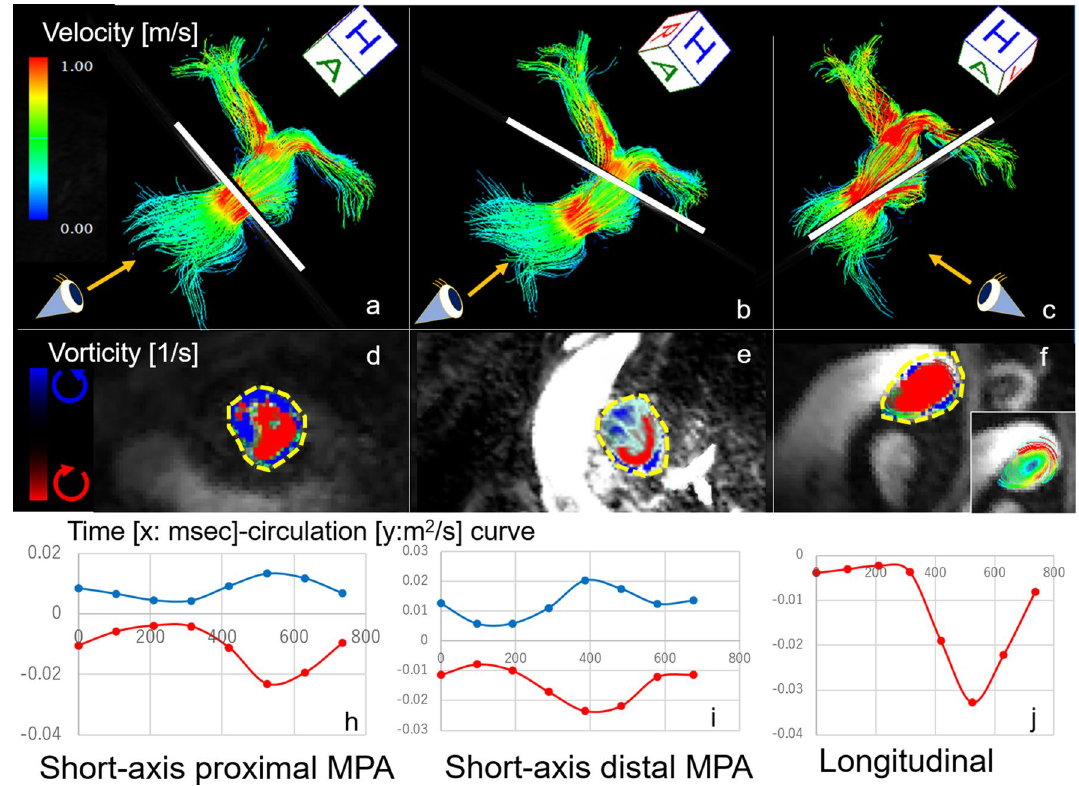
Figure 4. Streamline imaging flows of the pulmonary arteries of a 40-year-old man with repaired TOF (Case 6). The leftmost image and middle image show short-axis vorticities; the rightmost image shows a long-axis vorticity. The white lines in the uppermost row, where the vorticity was calculated, correspond to the cross sections shown in the middle row. The location of the measurement in the proximal MPA occurred at 1 cm above the pulmonic valve ( a : white line). The location of the measurement in the distal MPA occurred at 1 cm below the bifurcation of the MPA into the right and left pulmonary arteries ( b : white line). The longitudinal circulation was measured parallel to the clockwise systolic vortex in the MPA ( c : white line). Vortex formation in the 3 different cross sections of the main pulmonary artery demonstrates the clockwise vortices in red and the counterclockwise vortices in blue [ d : cross sections of the proximal MPA, e : cross section of the distal MPA, f : cross section of the vortex (middle row)]. The area surrounded by the yellow dotted line was the region where circulation (area integral of vorticity) was calculated ( d : short-axis proximal MPA, e : short-axis distal MPA, f : longitudinal). The region of interest for the longitudinal circulation manually traced the vortex that can be recognized by streamline analysis ( f : small square). The leftmost image and middle image show short-axis vorticities; the rightmost image shows a long-axis vorticity. The time-circulation curves show waveforms with 1 or 2 peaks ( h : short-axis proximal MPA, i : short-axis distal MPA, j : longitudinal). The red line represents clockwise circulation and the blue line represents counterclockwise circulation (lowermost row). Flow visualization was performed with the use of 4D-flow postprocessor software (iT Flow; Cardioflow Design. Inc., Tokyo, Japan). Time-circulation curves were created by Microsoft Office Excel Ver